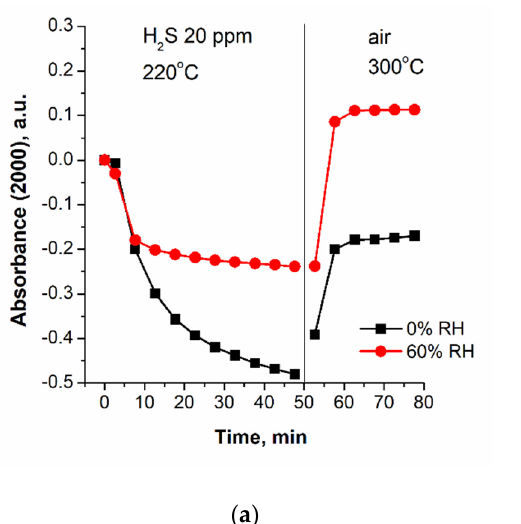
Figure 14. Baseline absorption at 2000 cm − 1 on DRIFT spectra: ( a ) Co 3 O 4 ; ( b ) Ni 0.1 Co 2.9 O 4 .